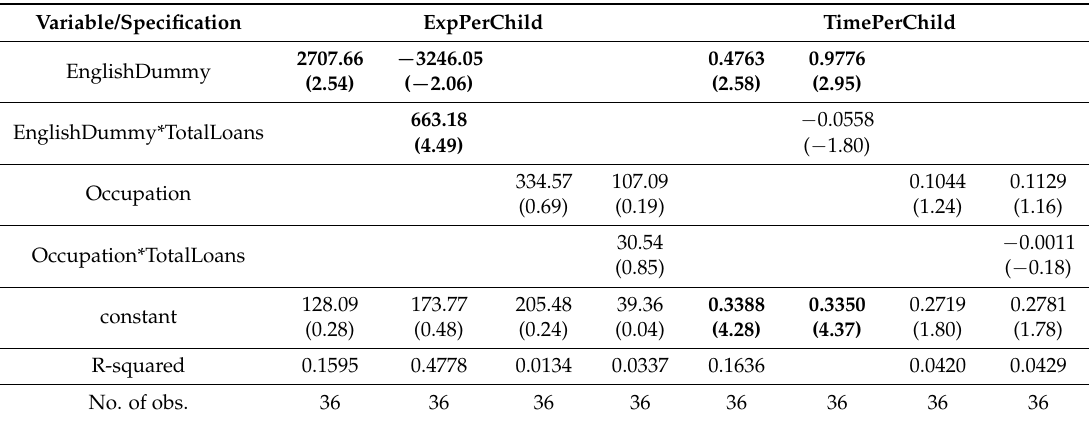
Table 4. Educational Investment and Class